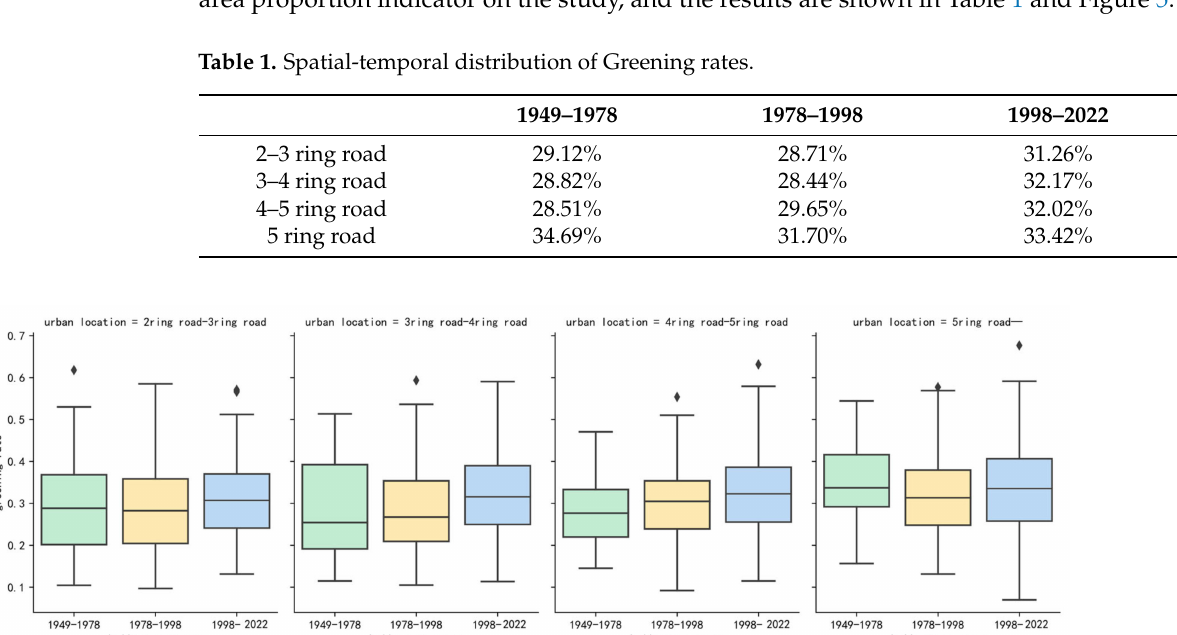
Figure 5. Spatial-temporal distribution of Greening rates.